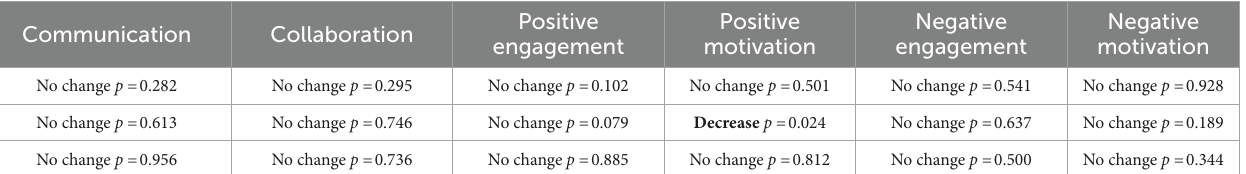
TABLE 4 Intake 2 quantitative changes over time (significant changes at p < 0.05 level in bold).